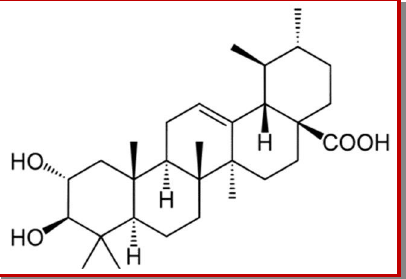
Figure 1: Chemical structure of corosolic acid- a pentacyclic triterpene acid